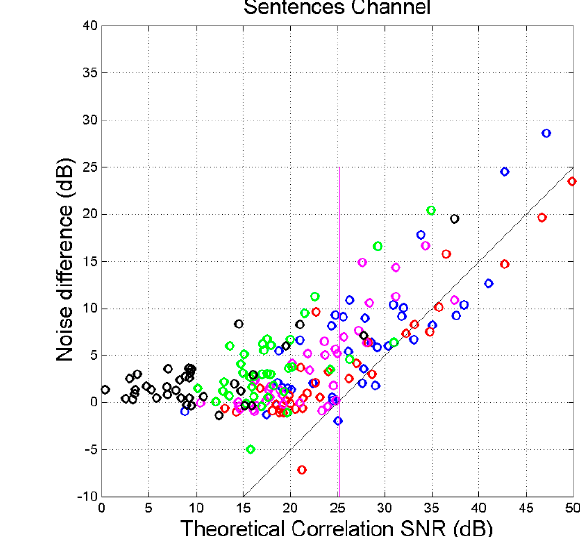
Figure 11. (Left panel ) : Scatter plot between the theoretical partial signal ‐ to ‐ noise ratio Γ (cid:3040),(cid:3031)(cid:3003),(cid:3047)(cid:3035) and the experimental Γ (cid:3040),(cid:3031)(cid:3003),(cid:3032)(cid:3051) in the indicated cross ‐ links. ( Right panel ): Difference Γ (cid:3040),(cid:3031)(cid:3003),(cid:3047)(cid:3035) (cid:3398) Γ (cid:3040),(cid:3031)(cid:3003),(cid:3032)(cid:3051) , i.e., the ratio (expressed in dB) between the noise power in the experimental channel and that in the theoretical channel. Color key : blue = Mt vs. Mk; red = Mt vs. Lk; magenta = Mt vs. Jh; green = Mt vs. Ac; black = Mt vs. Ap. The magenta line corresponds to Greek self ‐ channel.